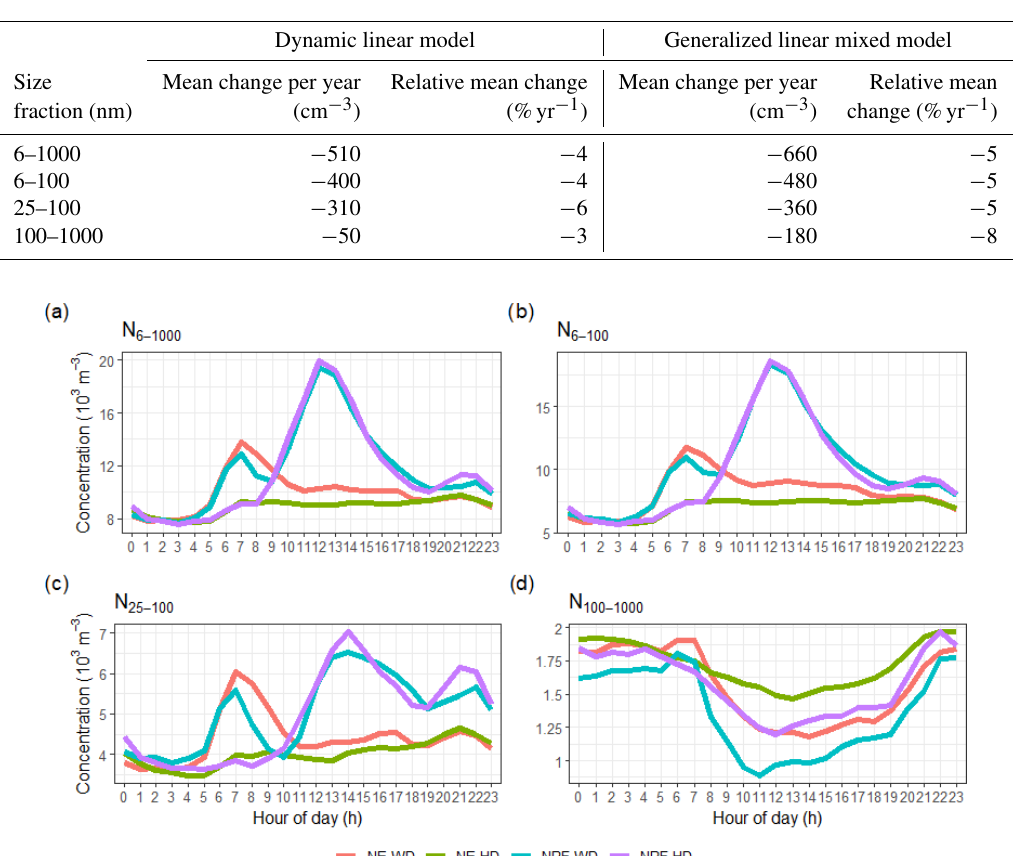
Table 3. Decrease rates of particle number concentrations in the diameter ranges from 6 to 1000nm, from 6 to 100nm, from 25 to 100nm and from 100 to 1000nm obtained by the dynamic linear model and generalized linear mixed model as a mean absolute change per year during the 10-year measurement interval and as a relative mean change per year with respect to the mean value of the first year.